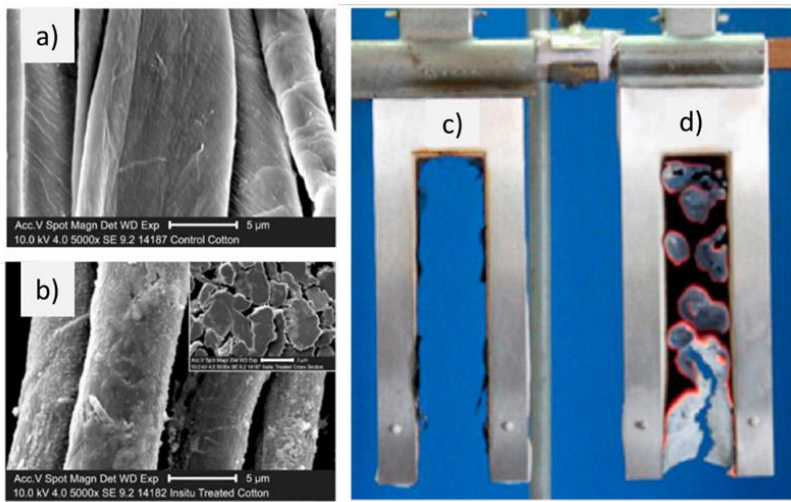
Figure 9. Surface morphology of control ( a ) and ZnO-treated ( b ) cotton fibres; flammability test of control ( c ) and ZnO-treated ( d ) cotton fabric. Reprinted with permission from [84]. Copyrights 2017 Springer.